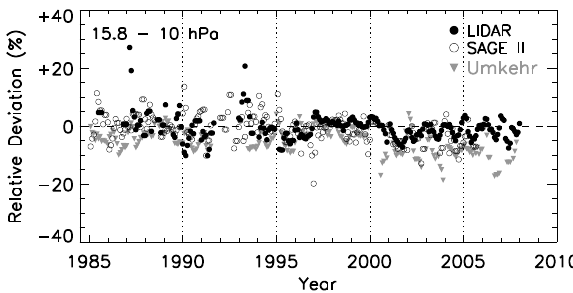
Fig. 5. Monthly average of therelativedifferences of collocated ozone column measurements of SBUV(/2)withlidar, SAGEII andUmkehr at 15.8–10hPa. The dashed horizontal line represents 0% and the dotted vertical lines represent year 1990, 1995, 2000, and 2005. Data are smoothed by 3-month running mean.